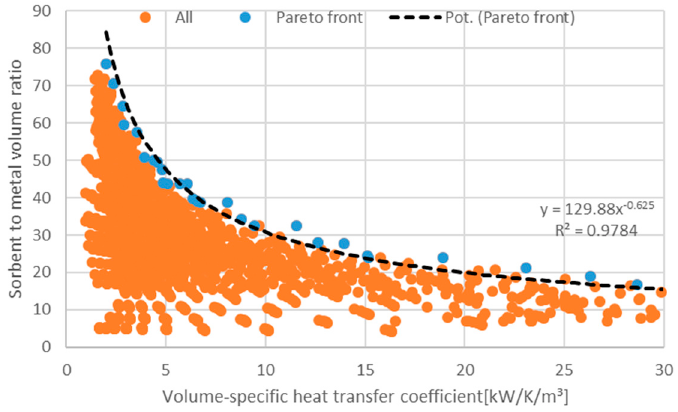
Figure 6. Results of the parameter variation for the SHX; blue dots correspond to the identified Pareto front.